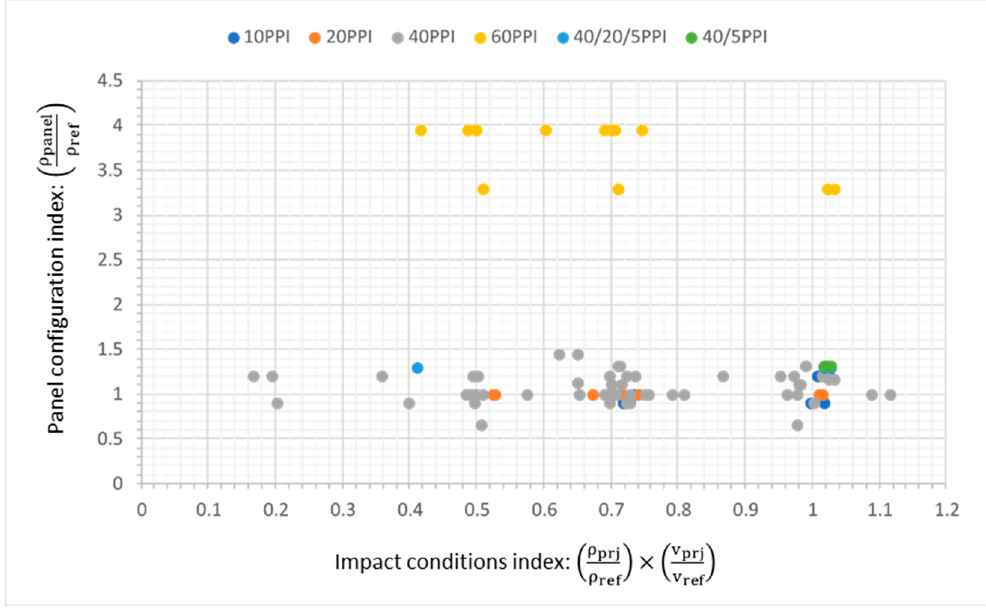
Figure 8. Foam ‐ core structures; panel versus projectile properties. Figure 8. Foam-core structures; panel versus projectile